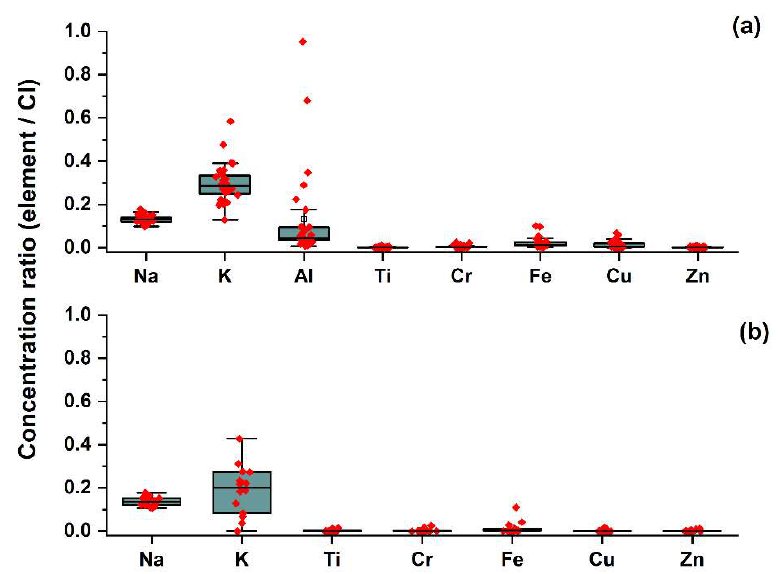
Figure 2. Box plots with overlapped data points for different trace elements in tears in ( a ) rural group (28 evaluations), ( b ) urban group (14 evaluations) normalized to chlorine. Quantification of the absolute values of the metal concentrations was based on PIXE data.